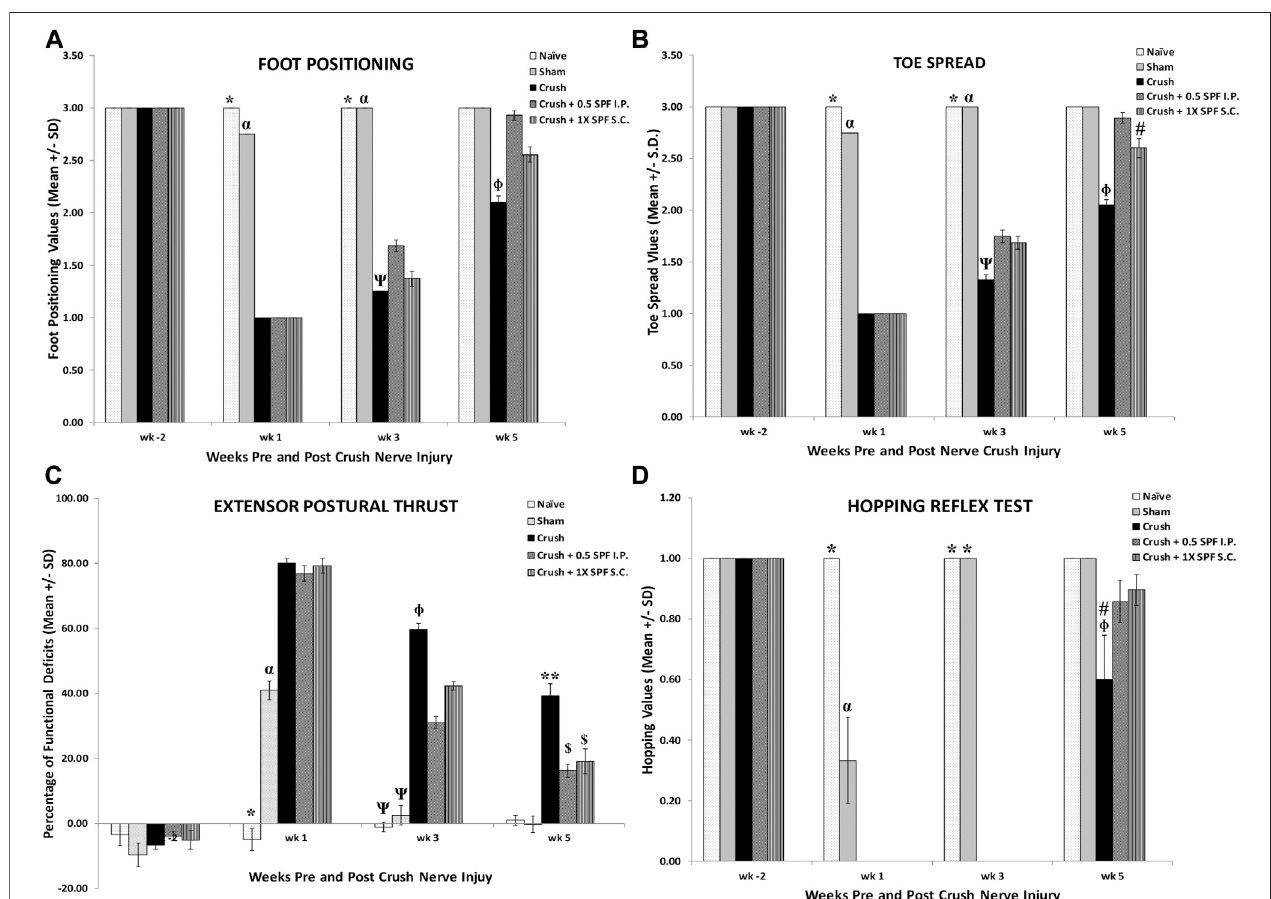
time latency on the Rotarod compared to the CRUSH group. Meanwhile, the Rotarod performance of the SPF-FB-treated animals displayed signi fi cantly ( p < 0.001) higher time latency (approximately 40 – 45 s) compared to the CRUSH group (nearly 25 s) at Week 5. The SPF-FB-treated groups showed no signi fi cant difference in time latency to the SHAM group (approximately 47